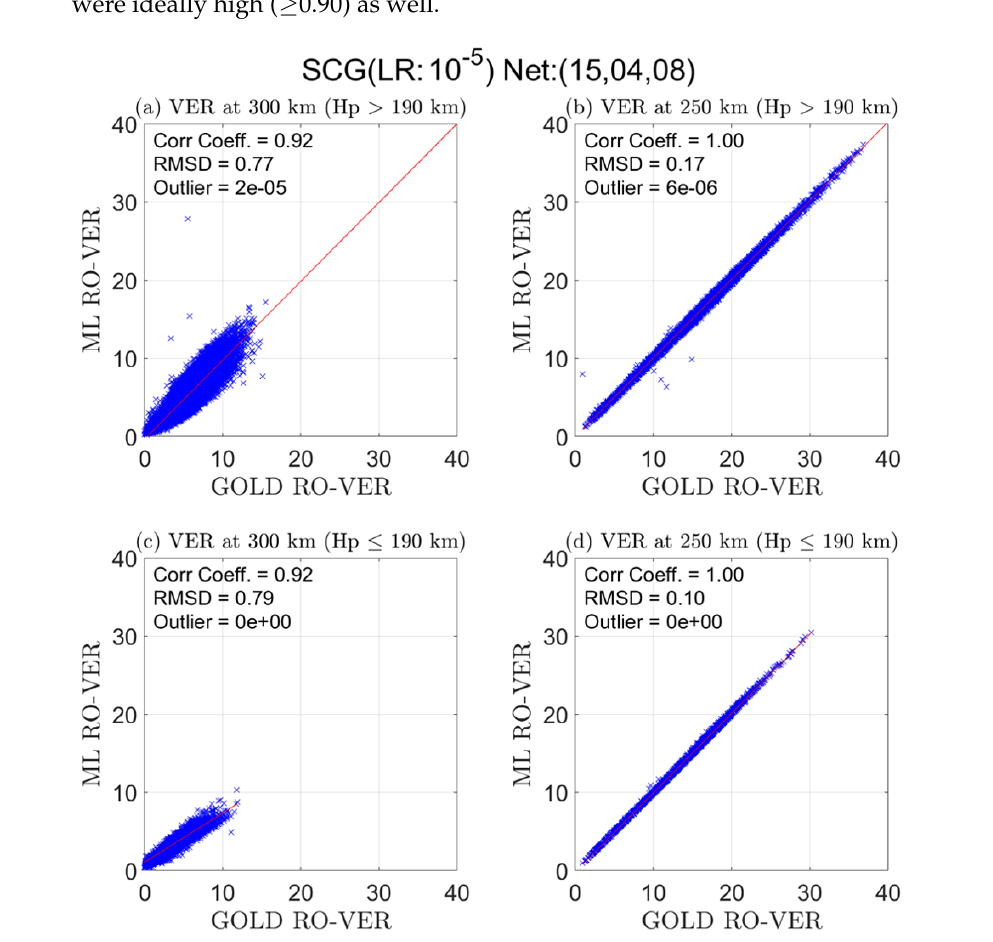
Figure 9. Similar to Figure 8, but with the hidden layers set as (15, 04, 08) and trained with the algorithm